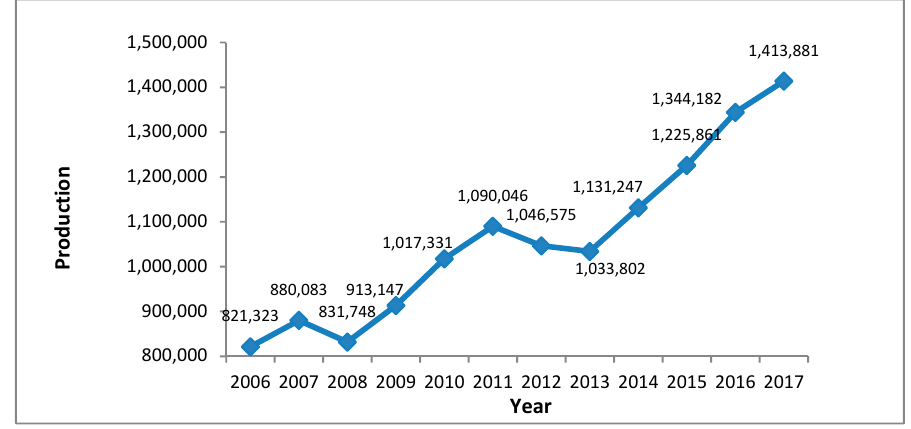
Figure 2. Production of passenger cars in the Czech Republic (CR) between 2006 and 2017 (according to [2]).